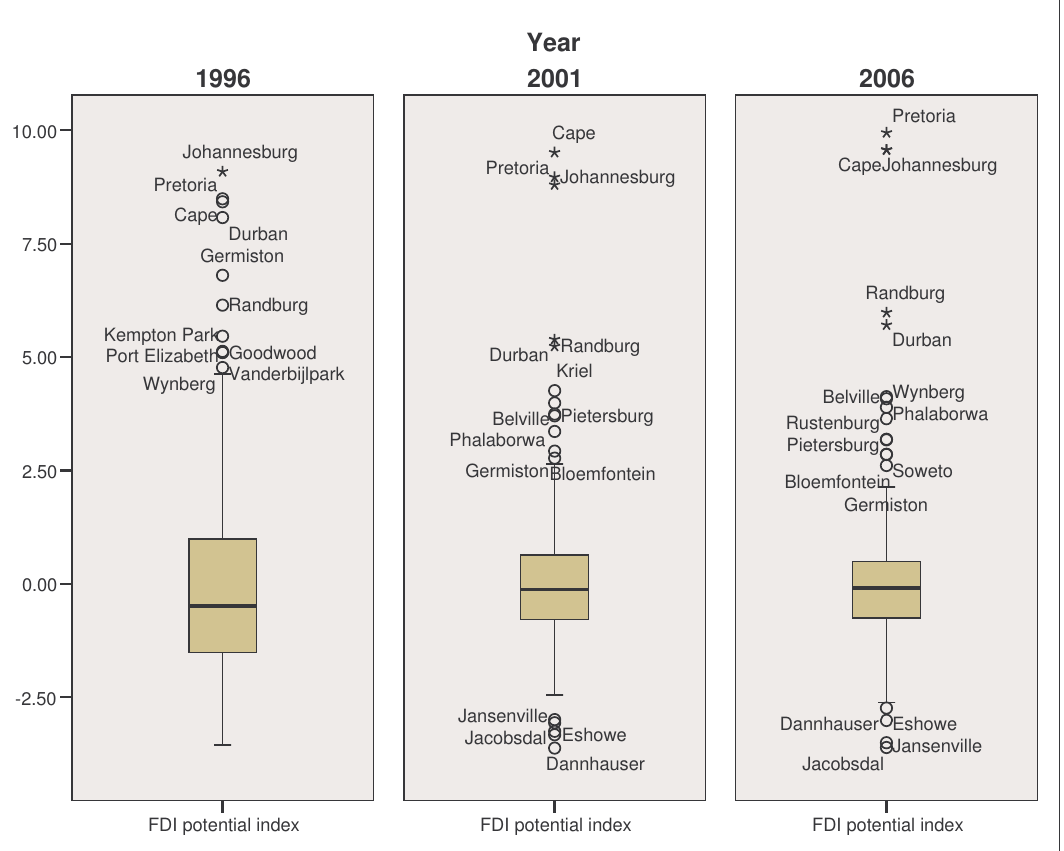
Figure 1: Box plots of the FDI potential index